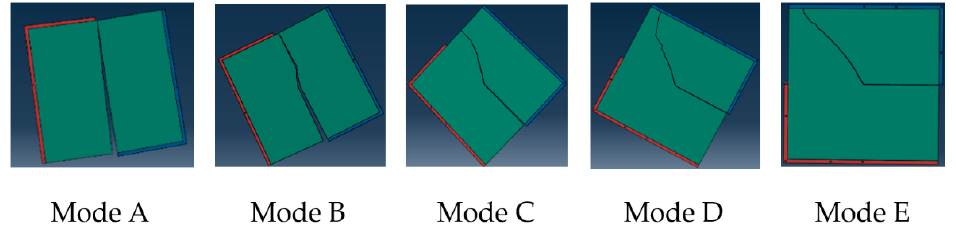
a 40 mm notch under five different mixed-mode levels. The crack angle is the acute angle formed by the straight line connecting the crack starting point with the crack end point and the cutting direction after the specimen is damaged. According to the simulation re- sults, the corresponding crack angles of the CR-20 mixture under five different mixed- mode levels (Mode A, Mode B, Mode C, Mode D, and Mode E) are 3°, 11°, 23°, 38°, and 44° respectively. Compared with the laboratory test results, it can be concluded that the virtual Arcan test has reasonable results. Arcan test has reasonable results.